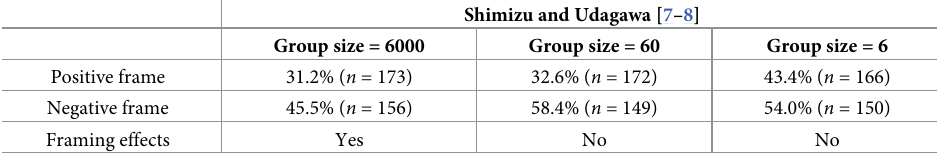
Table 2. Percentages of the probabilistic choice in the Life-Death decision problem across three sizes in a national survey (N =